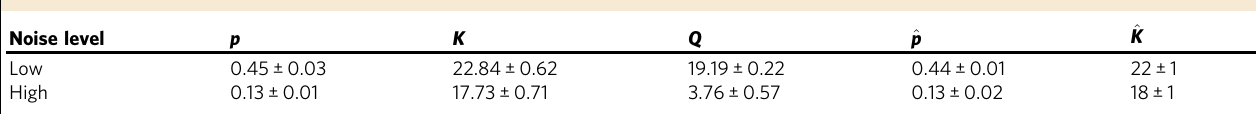
Table 1 Purity and dimensionality